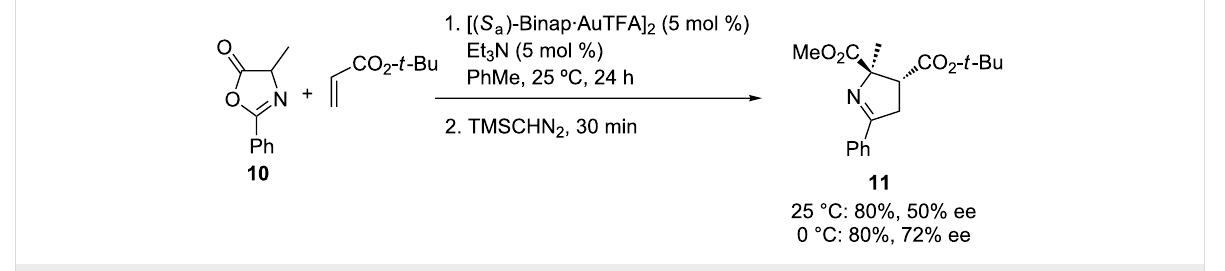
Scheme 6: 1,3-DC of azlactone 10 and tert- butyl acrylate.